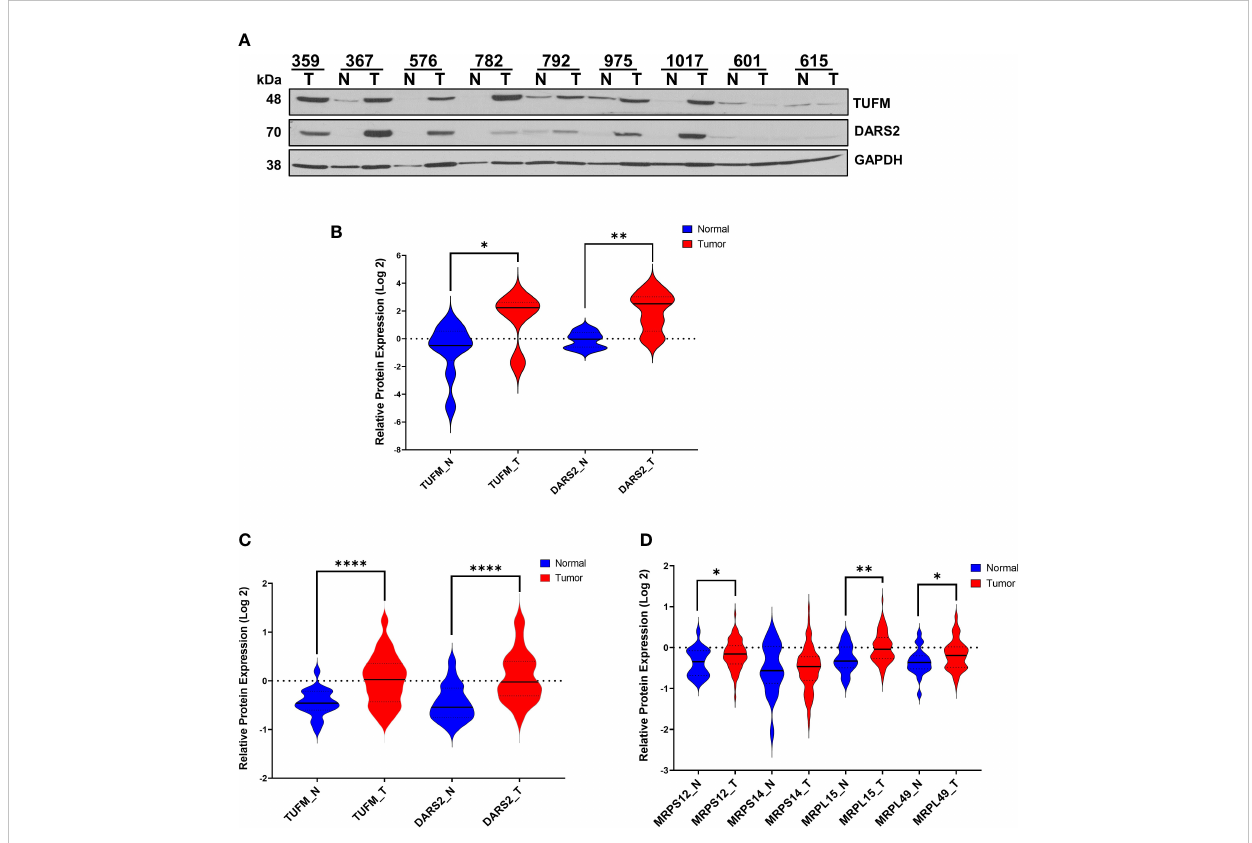
FIGURE 3 Expression of Mitochondrial Translation-Related Proteins in HGSOC. (A) Relative protein expression of TUFM and DARS2 were detected in normal ovarian (N) and HGSOC biopsies (T) by immunoblotting analyses. Equal protein loading was evaluated by Ponceau S staining and GAPDH probing. (B) Log 2 relative protein expression values of TUFM and DARS2 shown in panel A was presented using violin plots. (C) MS-based quantitation of TUFM and DARS2 protein expression, and (D) expression of mitochondrial ribosomal proteins, MRPS12, MRPS14, MRPL15, and MRPL49 in normal (N; blue) and HGSOC (T; red) in HGSOC published by McDermott et al. as part of the CPTAC data set [Log 2 values are taken from Supplemental Data in reference (45)]. P values ≤ 0.05 were represented as (*), ≤ 0.01 (**), and ≤ 0.0001